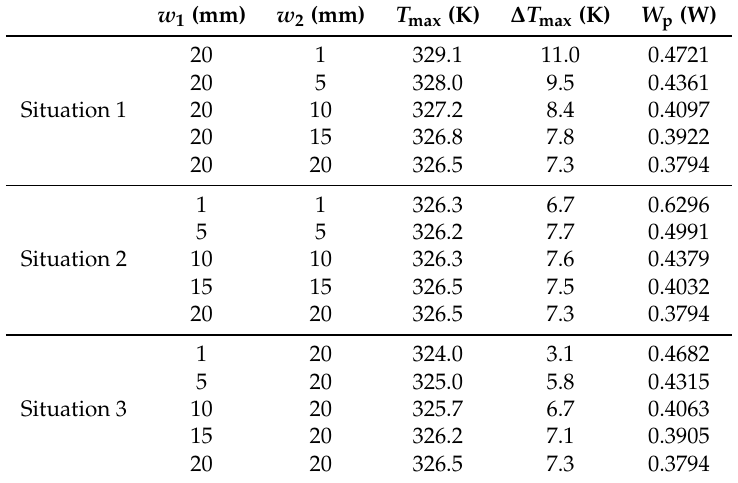
Table 8. Numerical results for various angles of the divergence plenum and convergence